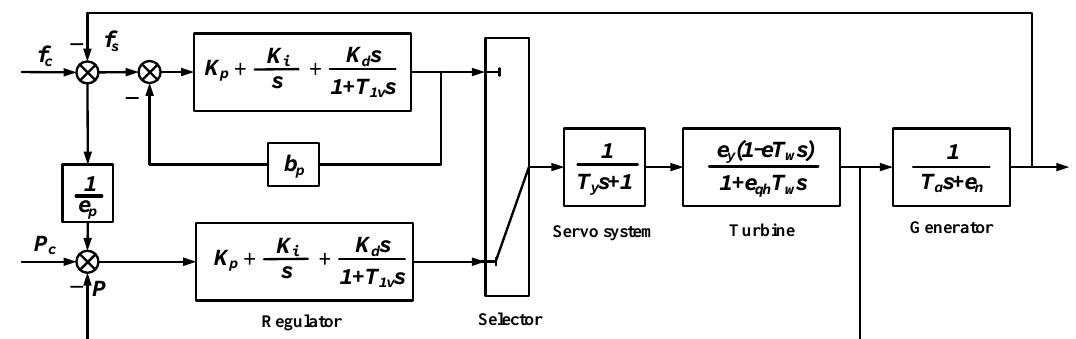
Figure 7. Integrated control mode of power and frequency.